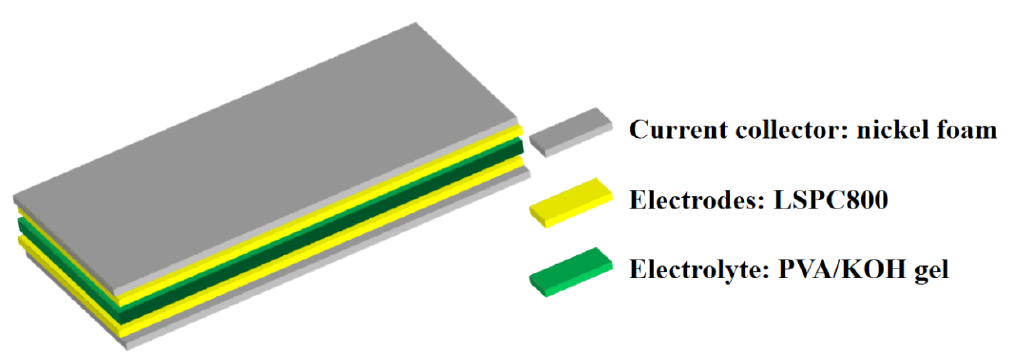
Figure 9. Schematic illustration of the all-solid-state SC device. PVA, polyvinyl alcohol.